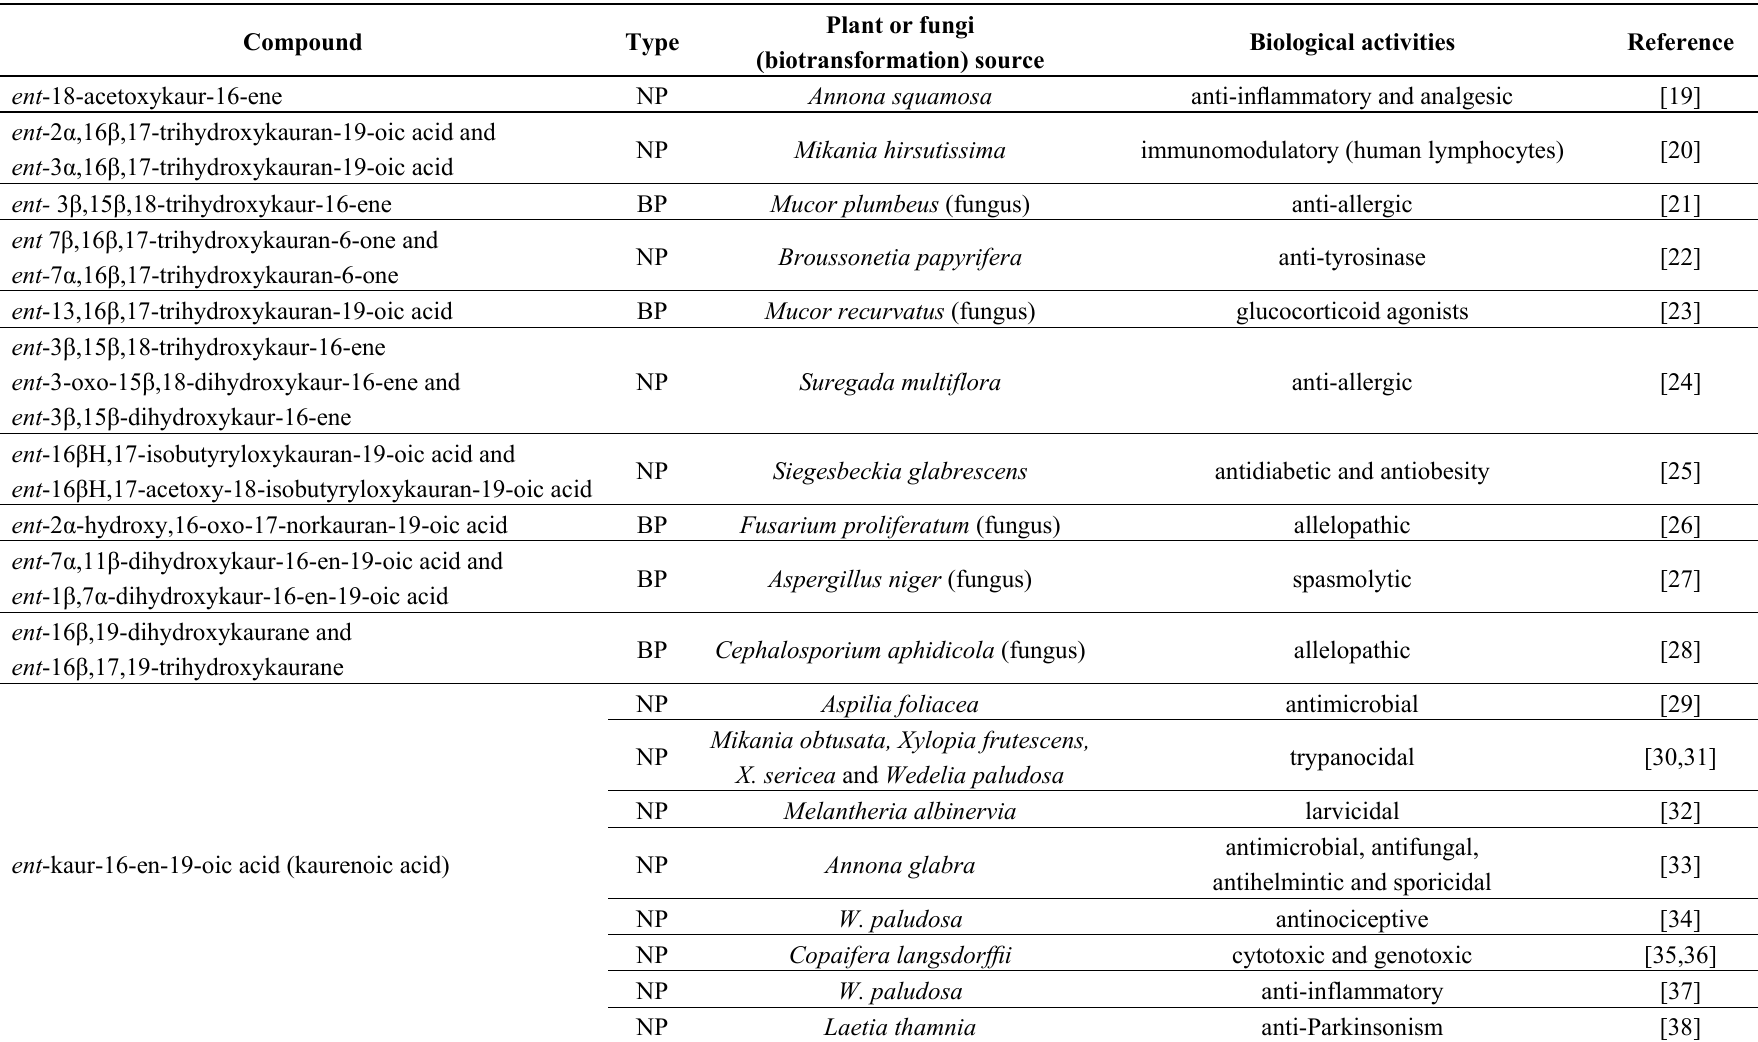
Table 1. Biological activities associated with kaurane